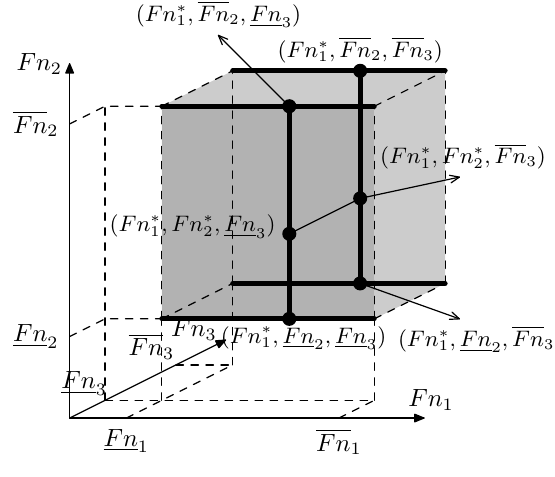
Fig. 3. Solving systems with three fuzzy